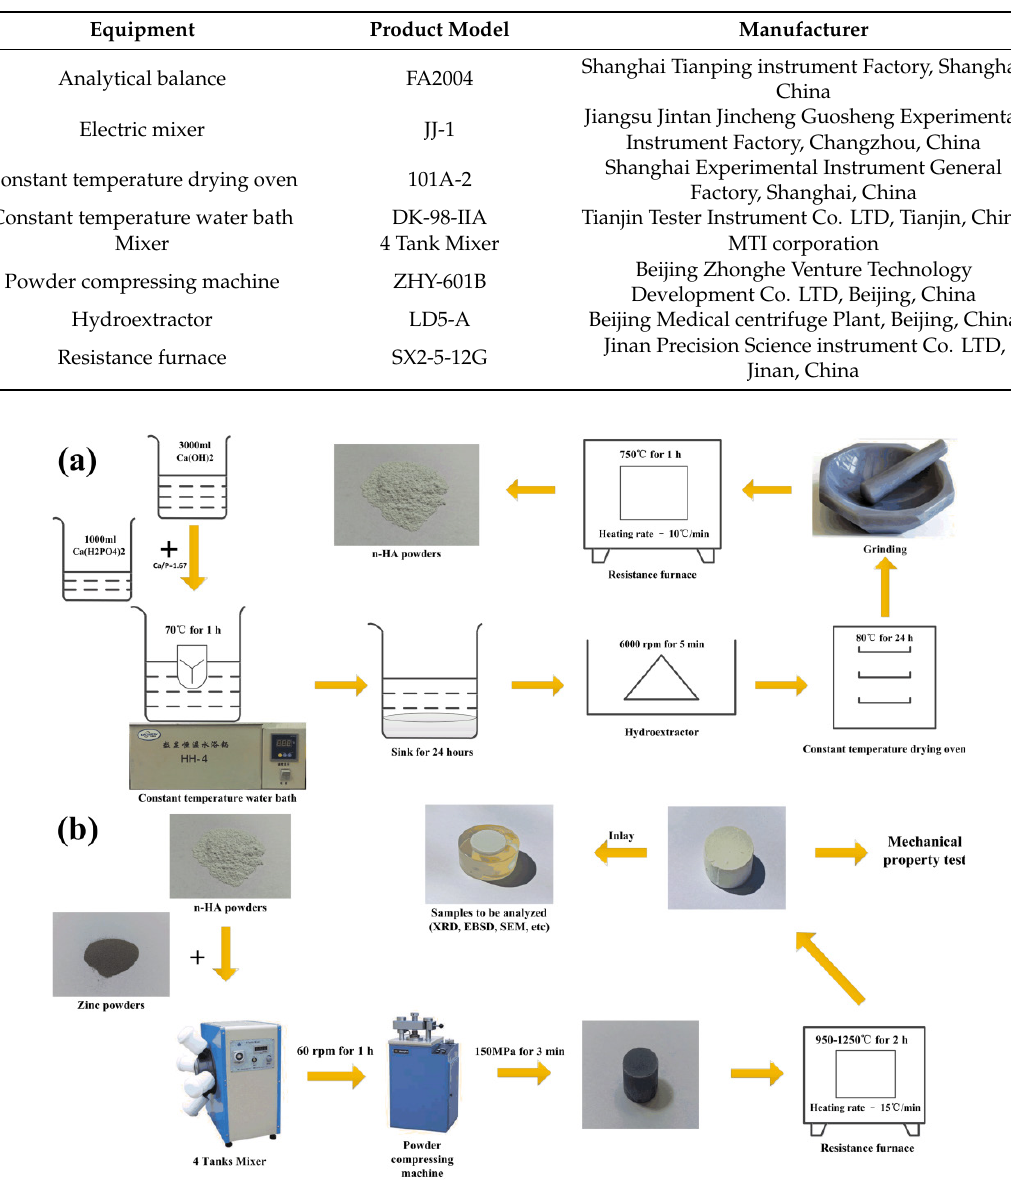
Figure 1. Preparation process of ( a ) nanometer hydroxyapatite (n-HA) powders and ( b ) ZnO/HA composites. Table 2. Composition and sintering process parameters (Bal., the mass fraction except for the other ingredient) of pure HA and ZnO/HA composites. Mass Fraction / Experimental Group